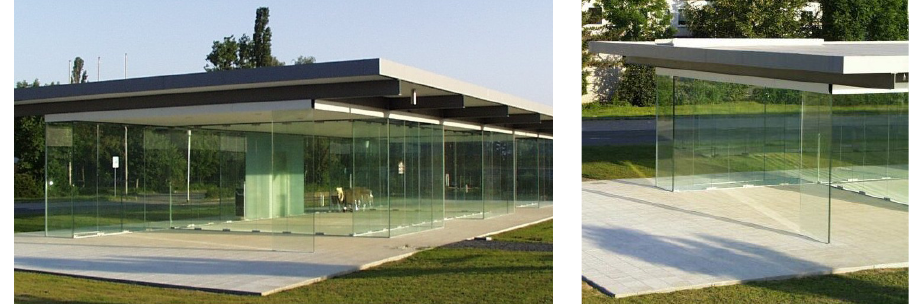
Figure 1: Application of pane-like glass columns: Glaspavillon Rheinbach (D).